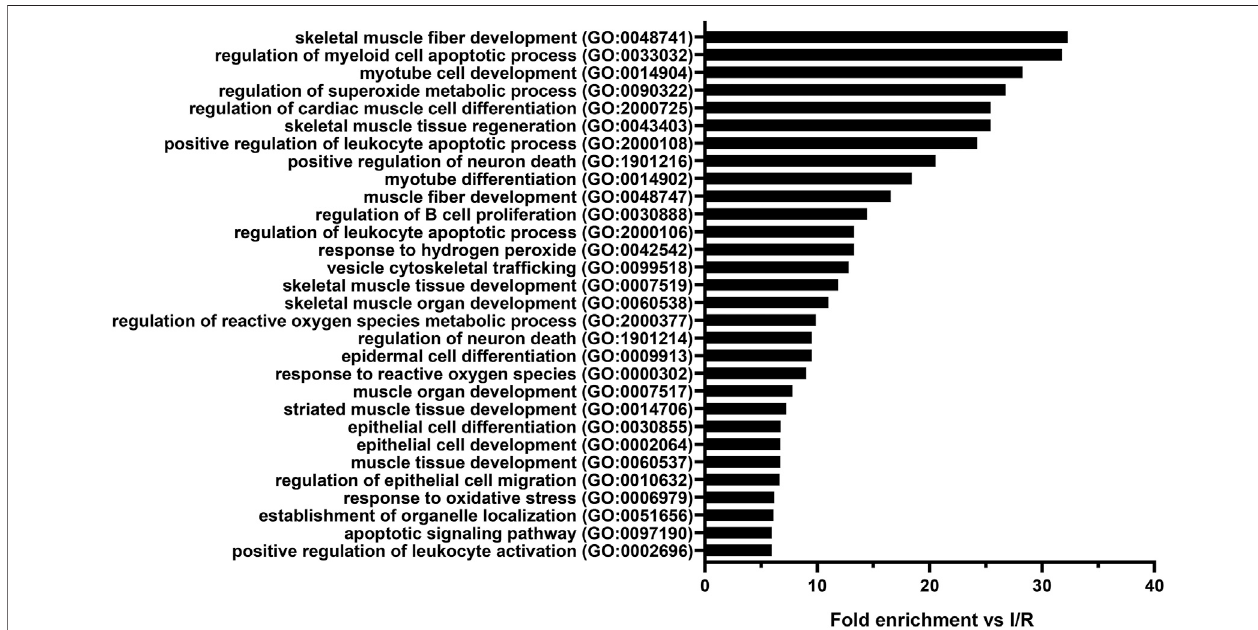
FIGURE 9 | Top thirty Gene Ontology (GO) biological process terms signi fi cantly enriched among the mRNAs (n (cid:2) 143) differentially expressed in the comparison between remote ischemic conditioning (RIC) and ischemia/reperfusion (I/R) groups in the order of decreasing fold enrichment values. GO enrichment analysis highlights the effect of RIC on skeletal muscle fi ber development, muscle tissue regeneration, cardiac muscle cell differentiation, superoxide metabolic processes, reactive oxygen species metabolic processes, and response to oxidative stress. Adjusted Fisher ’ s exact p values were < 0.05 in case of each shown process after false discovery rate adjustment for multiple